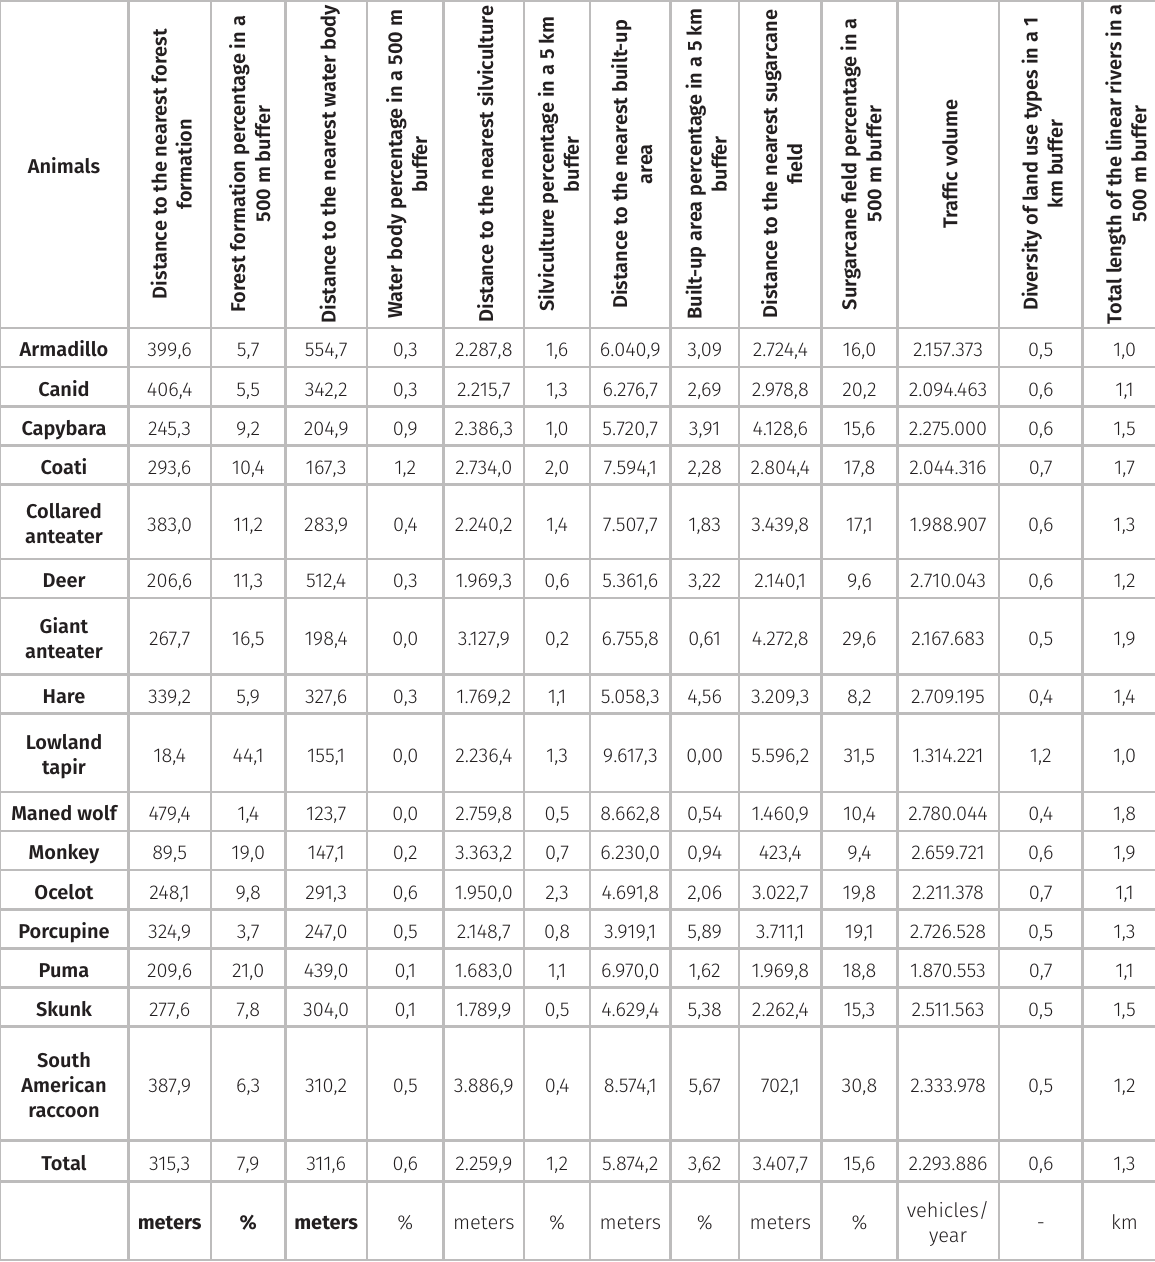
Table IV. Animals involved incrashes and the average for land cover and highway characterization variables.